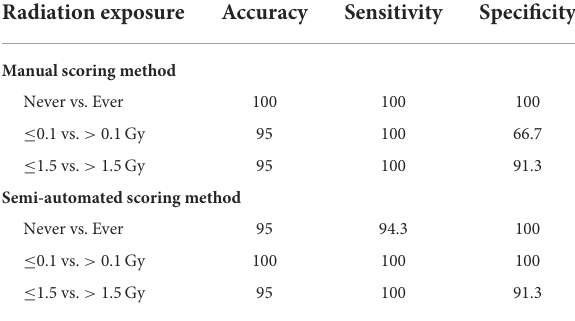
TABLE 2 Accuracy, sensitivity, and specificity of triage classification. Radiation exposure Accuracy